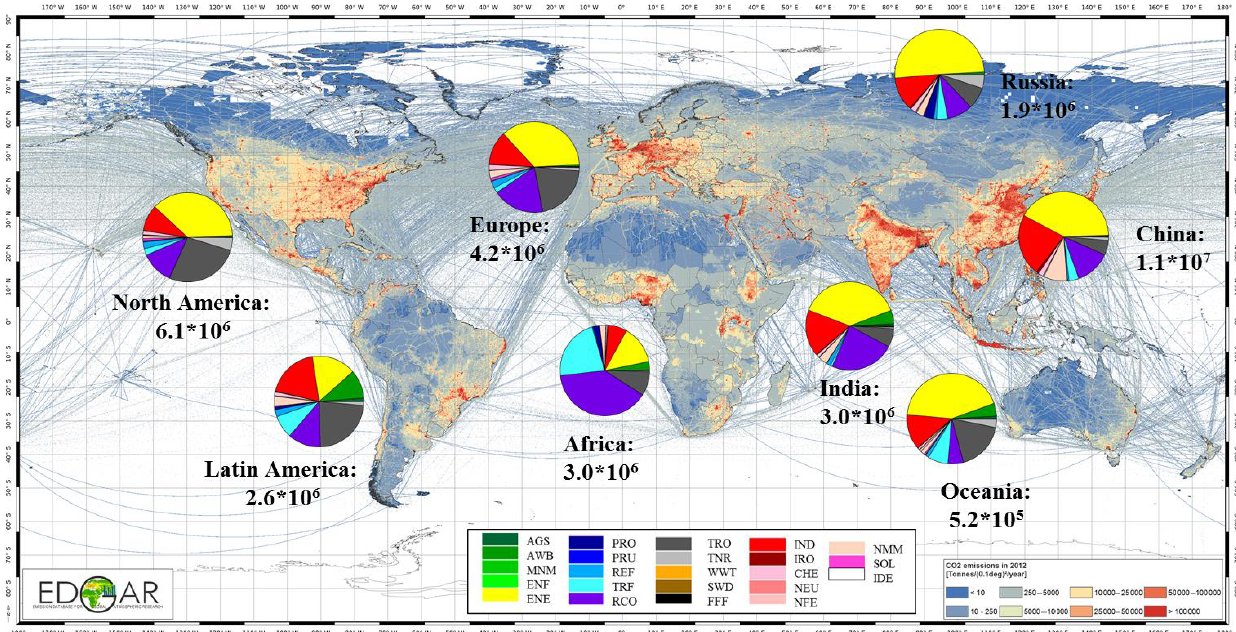
Figure 9. CO 2 emission grid map and relative contribution of EDGAR sectors in world regions (pie charts) for 2012. The legend for the PIE charts relates to the EDGAR sectors defined in Table S3: AGS: agricultural soils, AWB: agricultural waste burning, MNM: